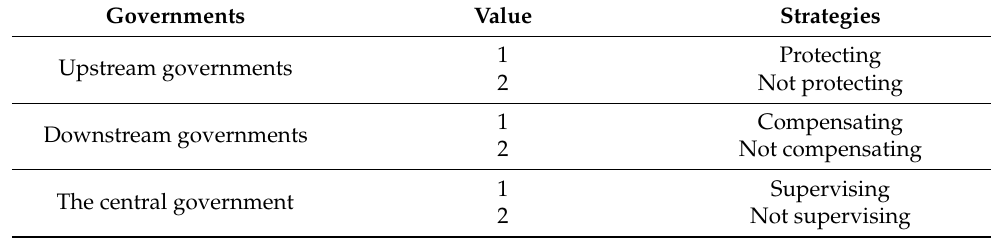
Table 1. Strategies for each player in the evolutionary game.